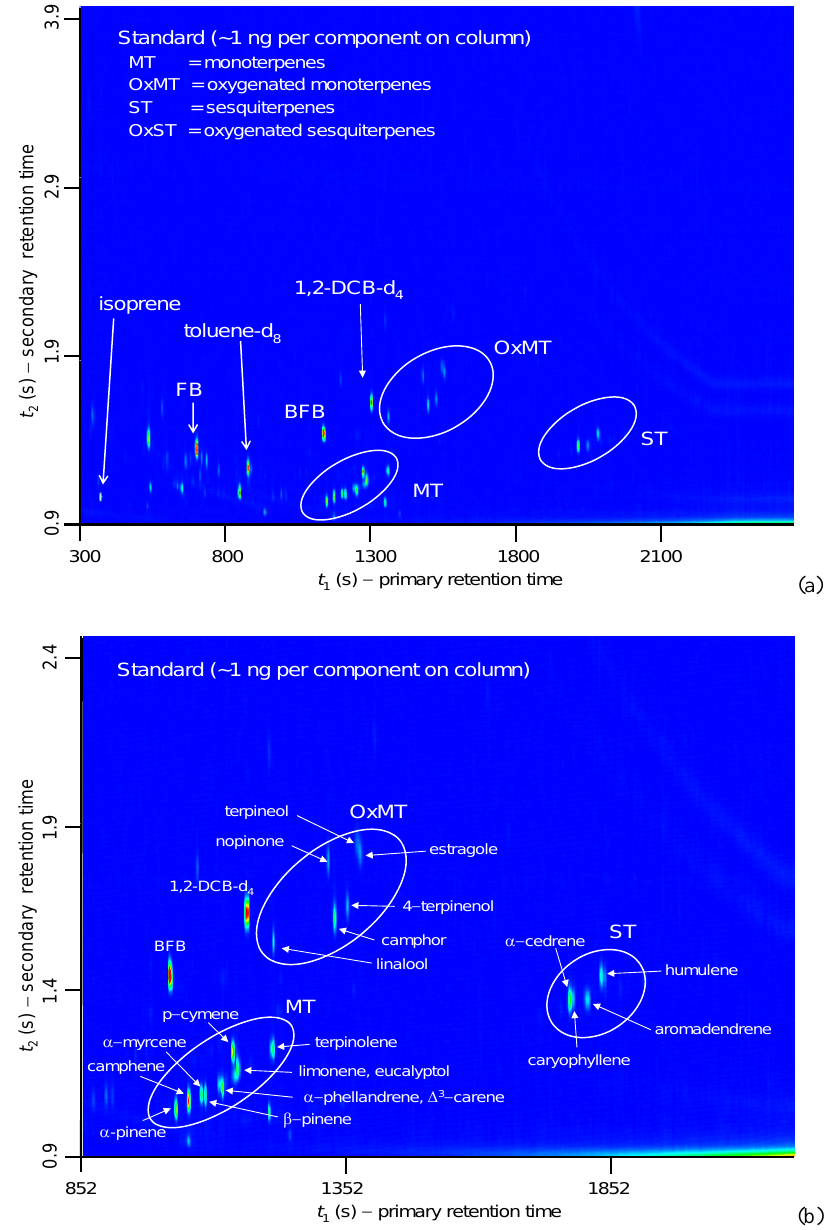
Fig. 2. (a) GC × GC-TOFMS chromatogram of a standard containing 21 VBOCs at ∼ 1ng per component on-column; internal standard compounds are fluorobenzene (FB), toluene-d8, bromofluorobenzene (BFB), and 1,2-DCB-d4 (1,2-dichlorobenzene-d4); obtained using the improved chromatographic conditions (Table 3). (b) Enlarged region of GC × GC-TOFMS chromatogram showing 20 VBOCs at ∼ 1ng per component